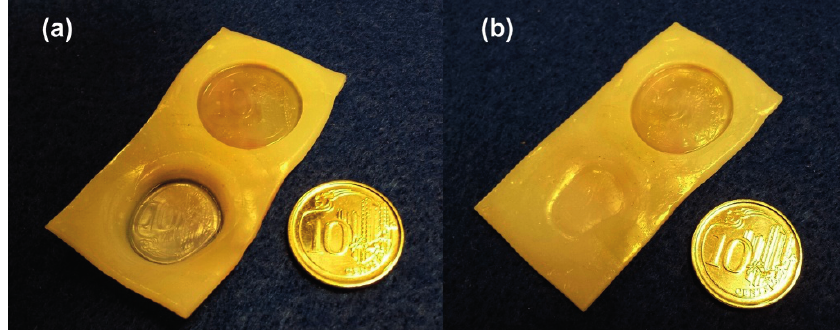
melting temperature; bottom: impressed at room temperature; and ( b ) after heating in boiling water.